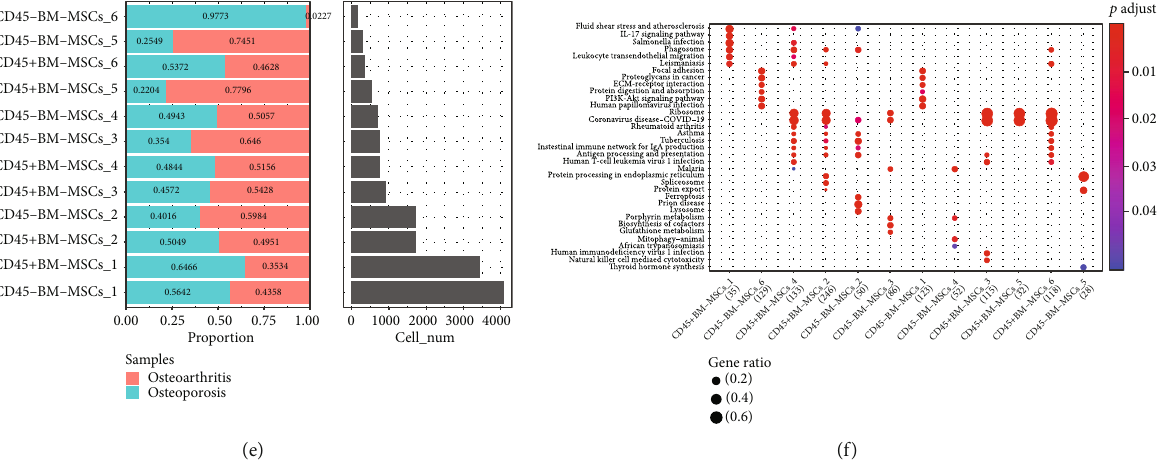
Figure 1: Single-cell RNA analysis of osteoporosis patients and osteoarthritis patients. (a) t-Distributed stochastic neighbor embedding of two samples. (b) t-Distributed stochastic neighbor embedding of 12 subpopulations. (c) t-Distributed stochastic neighbor embedding of 12 subpopulations after BM-MSCs cell annotation. (d) The proportion and cell numbers of 12 subpopulations in two samples. (f) Kyoto Encyclopedia of Genes and Genomes enrichment analysis of 12 subpopulations. Table 1: Di ff erential analysis of cell types.